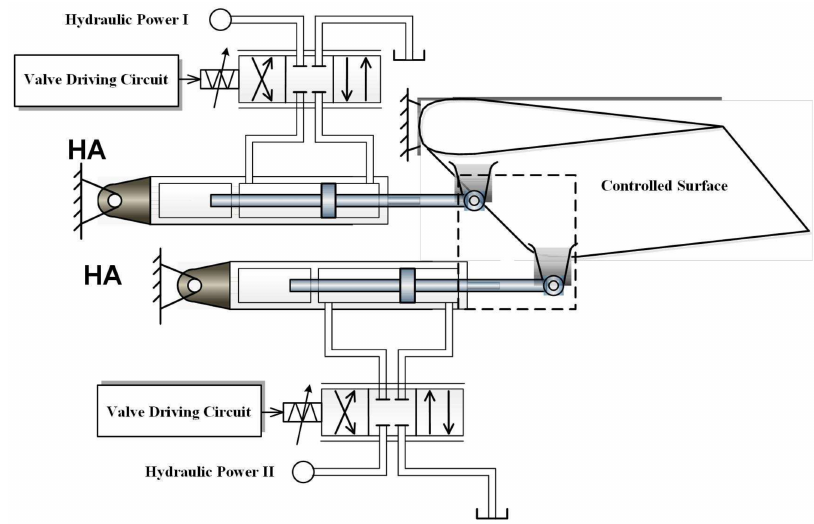
Figure 2. Configuration of actuation system with two HAs.